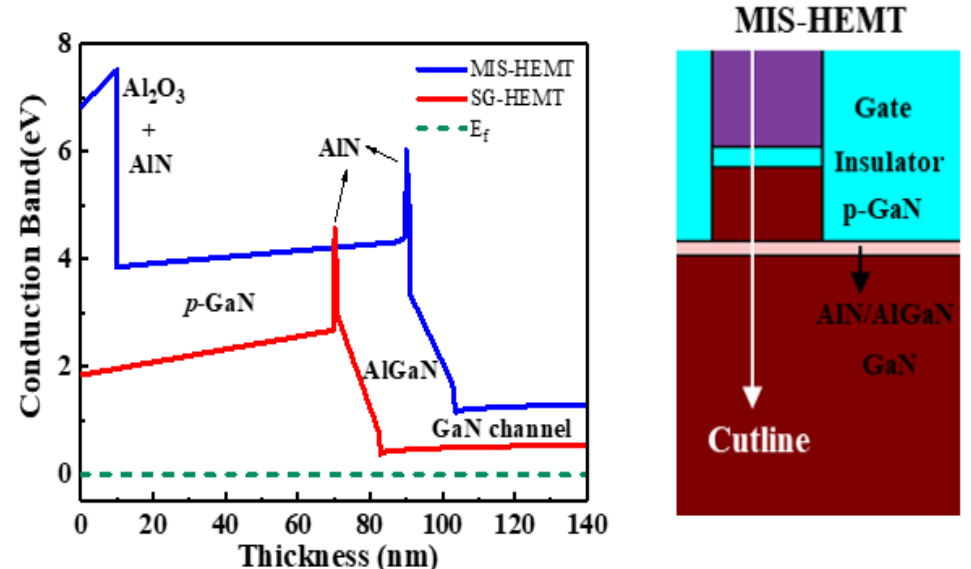
Figure 2. Energy band diagrams of schottky-gated high electron mobility transistor (SG-HEMT) and metal–insulator–semiconductor-high electron mobility transistor (MIS-HEMT) obtained through TCAD simulation.